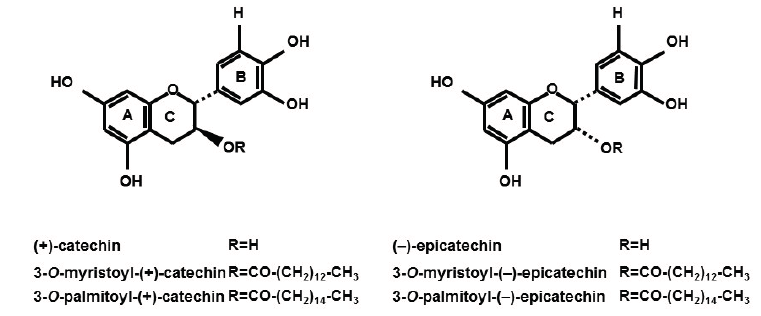
Figure 1. The chemical structures of 3- O -acyl-catechins.